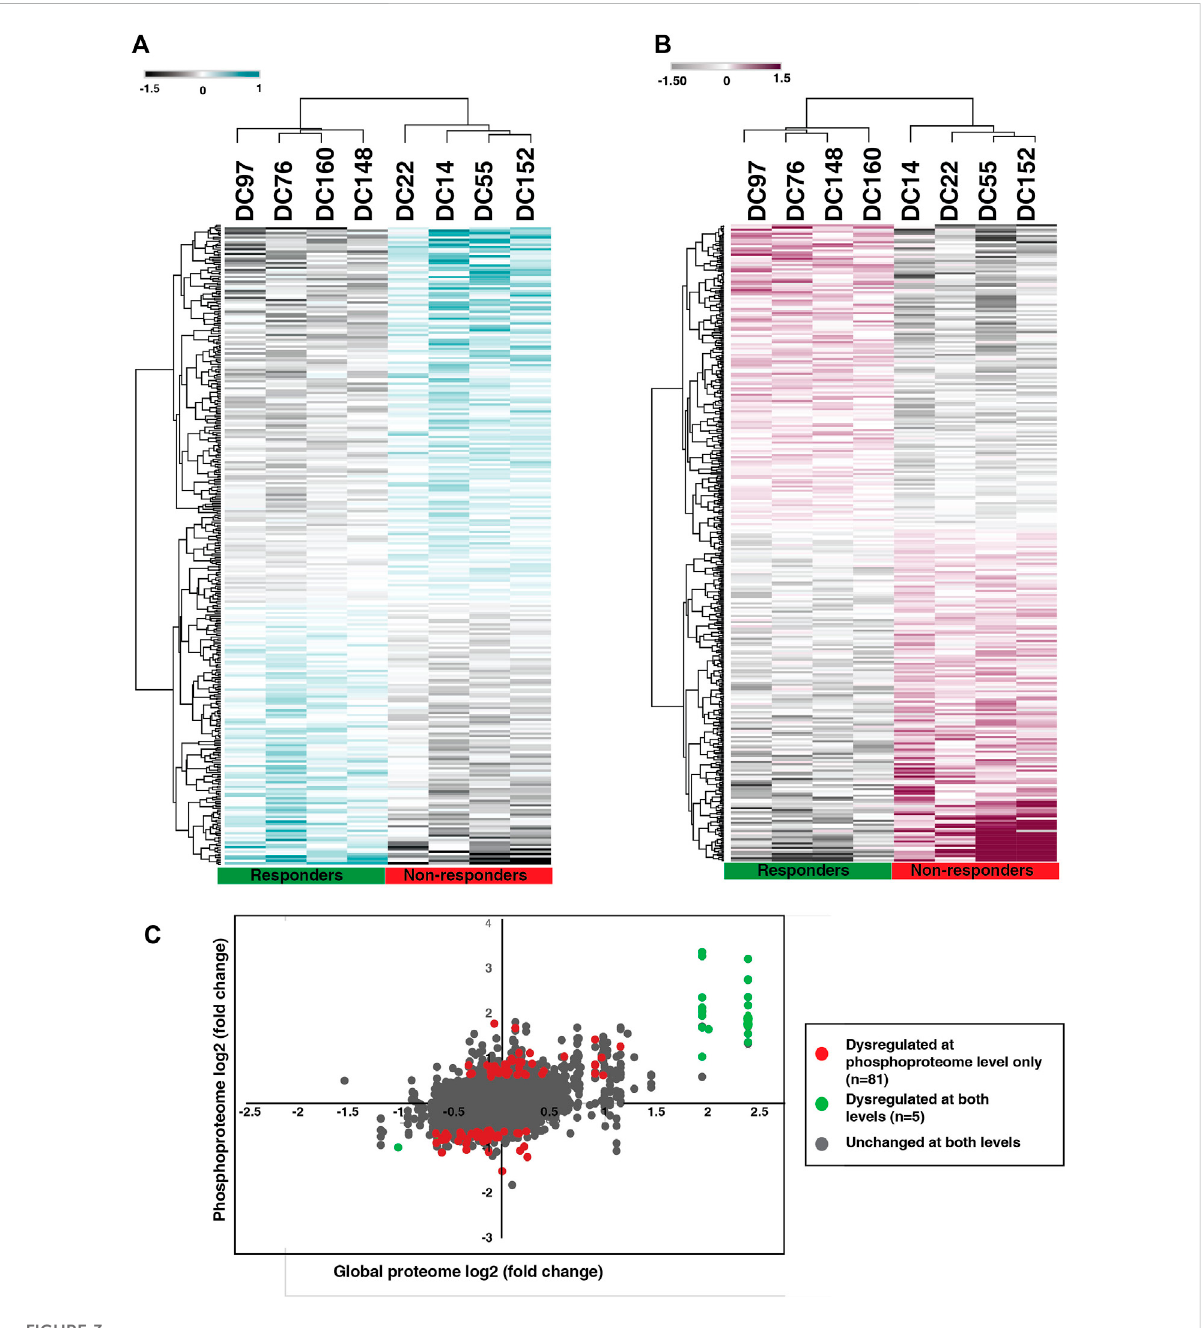
FIGURE 3 Proteomic and phosphoproteomic signature of NACT resistant TSCC patients. (A) Unsupervised clustering of signi fi cantly expressed proteins between NACT resistant and sensitive patients. Abundance values of signi fi cantly expressed proteins are represented in the heatmap. (B) Unsupervised clustering of signi fi cantly phosphorylated peptides in NACT resistant and sensitive patients. Abundance values of signi fi cantly phosphorylated peptides are represented in the heatmap. (C) Scatter plot comparing the protein expression and phosphorylation. Red datapoints represent differential phosphorylation with fold change ≥ 2 without any change in proteomic data and green datapoints with fold change ≥ 2 that are changed in both proteomic as well as phosphoproteomic data. Grey datapoints represent proteins that are unchanged in both